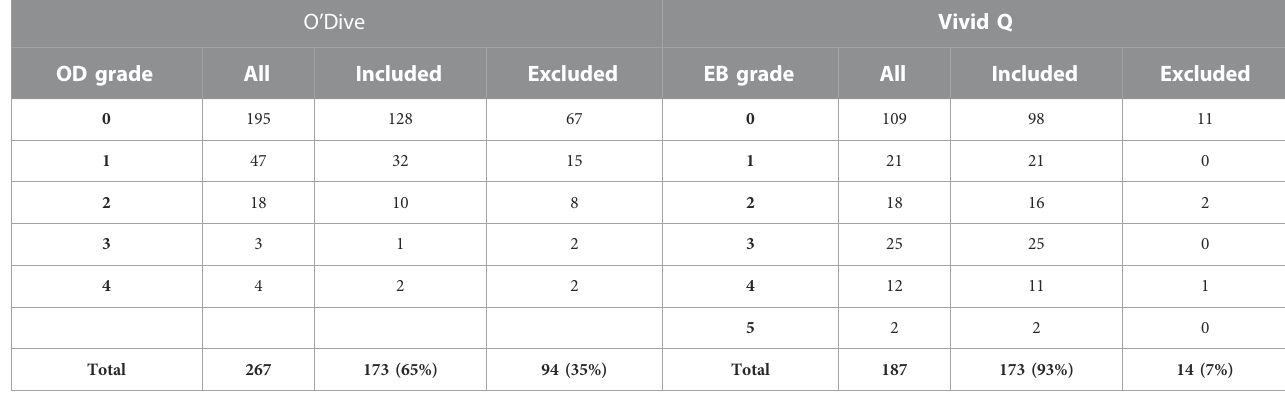
TABLE 1 Number of VGE measurements included in comparative study and excluded measurements from O ’ Dive and Vivid Q. O ’